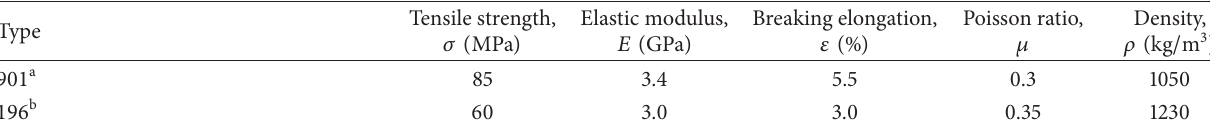
Table 2: Properties of resins.